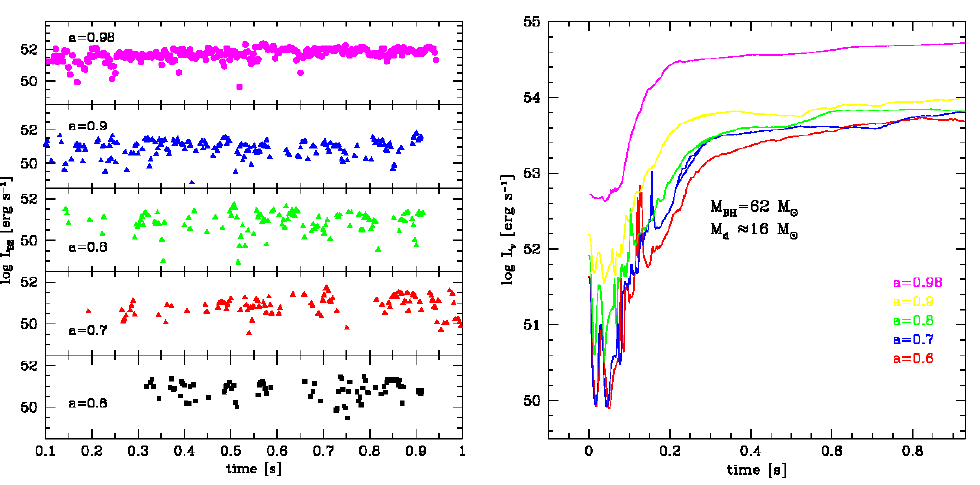
Figure 4. Power available in the GRB engine through the neutrino emission ( right ), and through the magnetic field advected under the BH horizon ( left